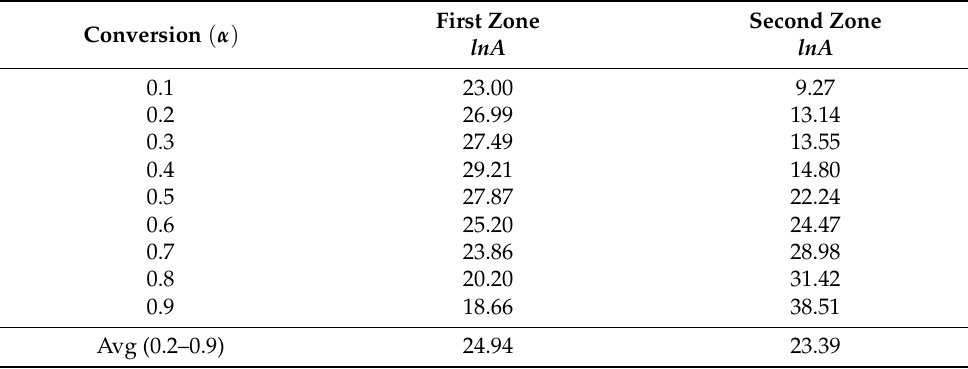
Table 9. Pre-exponential factor from FWO method for CS:WPCBs. First Zone Second Zone Conversion ( α ) lnA